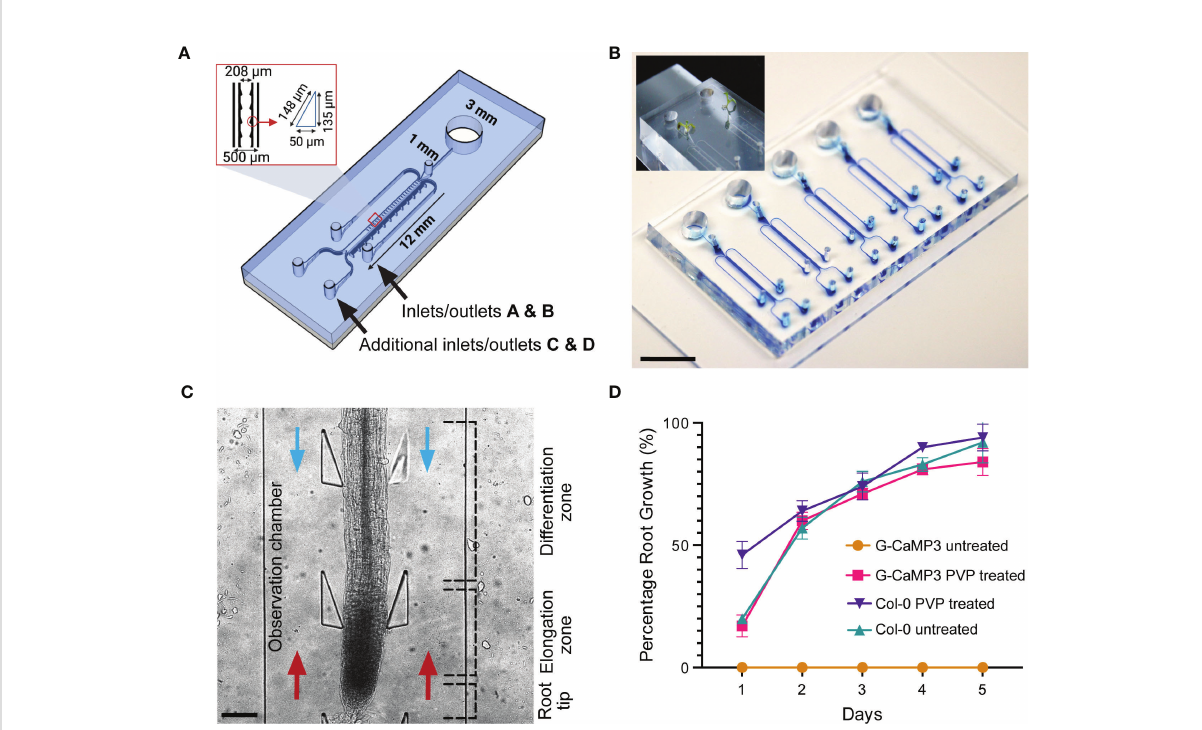
FIGURE 1 Bi-directional dual- fl ow-RootChip (Bi-dfRC) for laminar fl ow perfusion of stress treatments at the tip and differentiation zone of Arabidopsis roots. (A) Schematic diagram of the bi-dfRC including pillar array dimensions (identical to the conventional dfRC) in addition to a second set of inlets/outlets C & D for bi-directional stress application at the tip or differentiation zone. (B) Image of epoxy dye (blue) fi lled microchannels for visualisation of root observation chamber joining 4 inlet/outlets. 9-day old Arabidopsis G-CaMP3 plants cultured into the root inlet of the bi- dfRC depicted top left (scale bar 10 mm). (C) Arabidopsis G-CaMP3 root situated in the bi-dfRC observation chamber highlighting key zones (tip, elongation, and differentiation zone) and treatment orientation (blue arrows from top inlets A & B, red arrows from bottom inlets C & D, scale bar 200 µm). (D) Average percentage of Arabidopsis G-CaMP3 and Col-0 root growth into PVP-treated and untreated microchannels over 5-days (n=